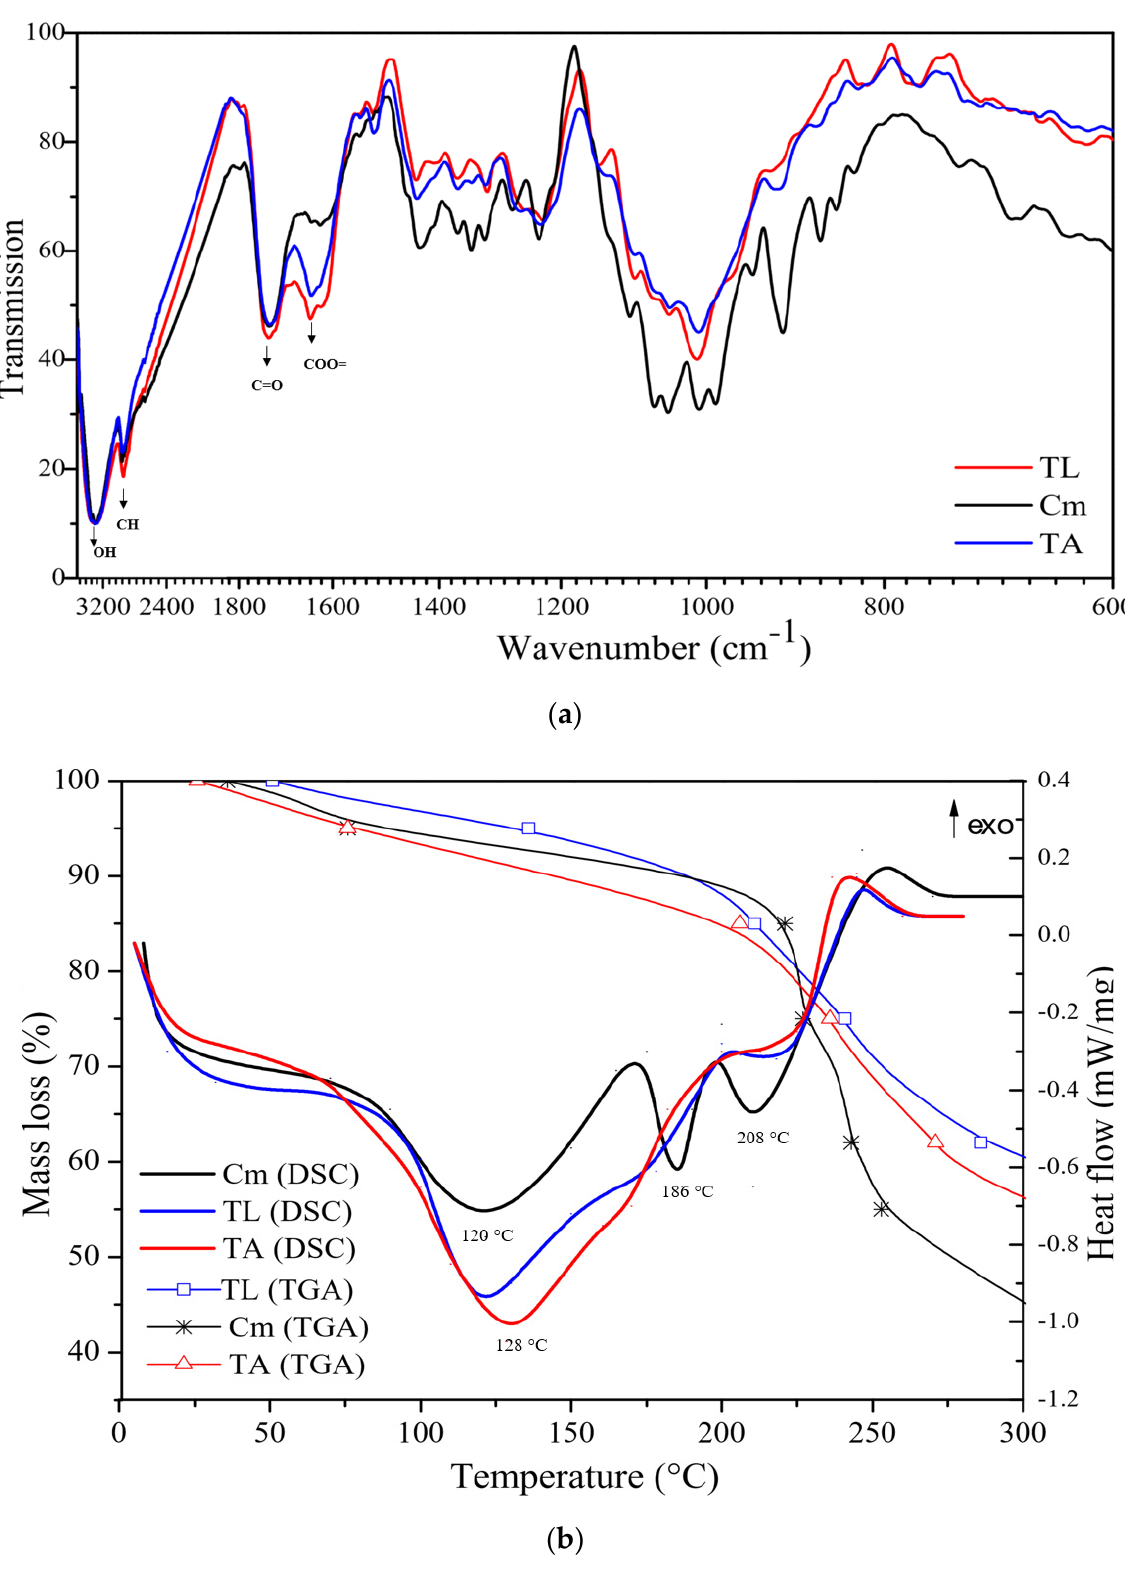
Figure 2. Tahiti lime (TL), King mandarin (MK), and commercial pectin (Cm): ( a ) Infrared spectra; ( b ) DSC and TGA thermal analyses.